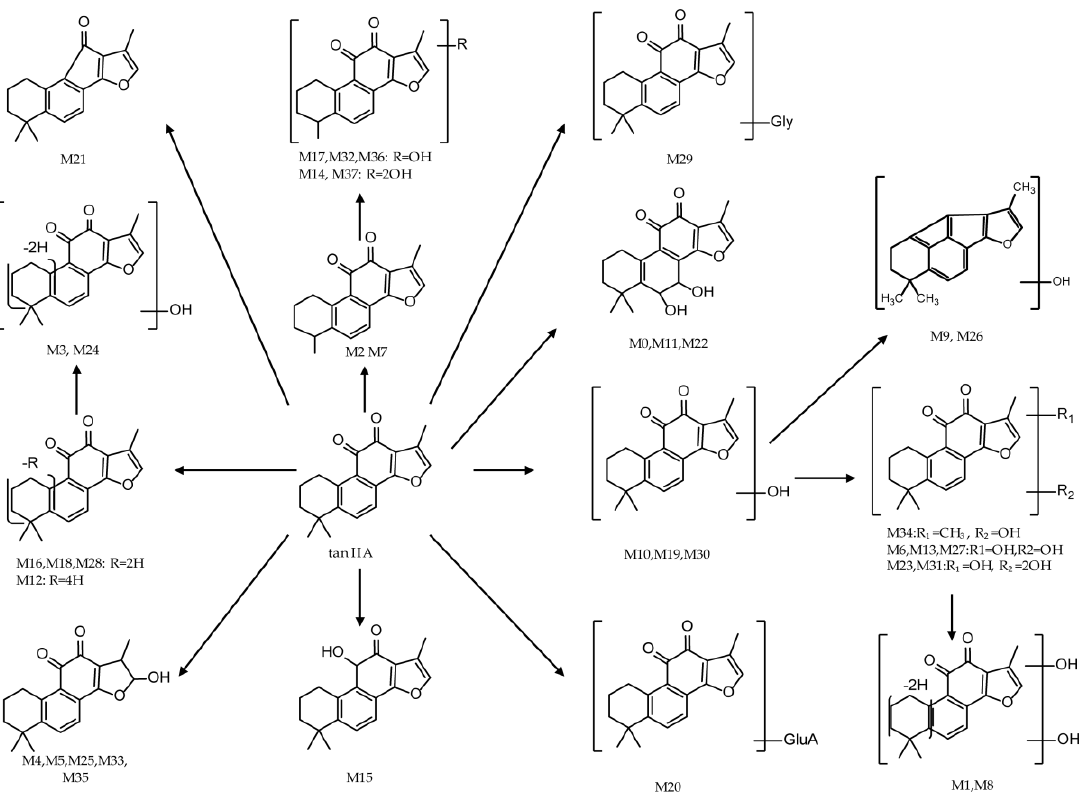
Figure 5. The proposed tanshinone IIA metabolic patterns in vivo.